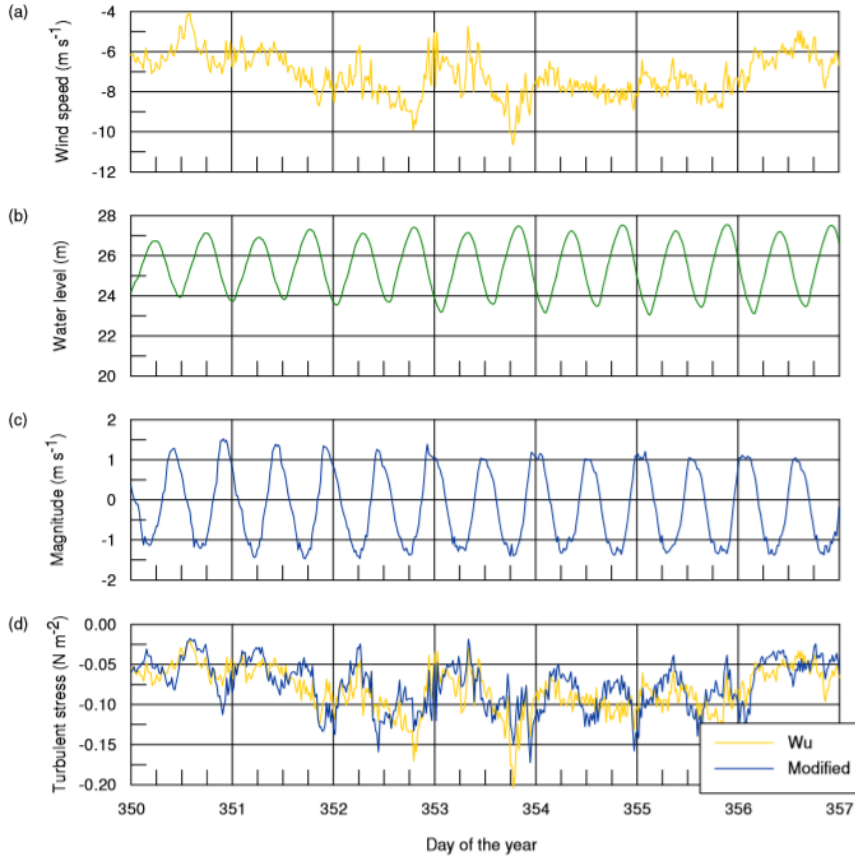
Figure 6. Marajó station time series for: ( a ) zonal wind speed, ( b ) water level variations, ( c ) zonal depth averaged current magnitude; and ( d ) a comparison between the zonal components of the surface turbulent stress obtained by using a neutral wind drag coefficient C DN and by using the modified method described in this paper.